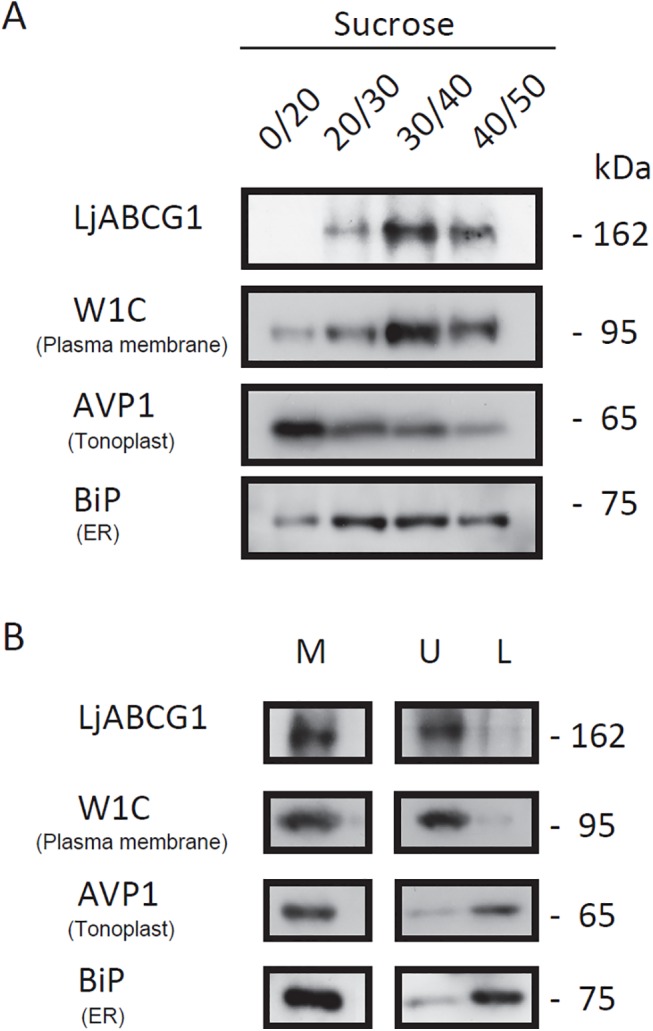
Subcellular localization.(A) Total microsomes from super roots were fractionated on a discontinuous sucrose gradient consisting of 20%, 30%, 40%, and 50% (w/v) sucrose. Membrane fractions were collected from the interfaces between different sucrose concentrations and analyzed via SDS-PAGE and western blotting. Blots were probed with antisera to LjABCG1, PM H+-ATPase (W1C), tonoplast and endomembrane H+-PPase (AVP1), and endoplasmic reticulum BiP (BiP). (B) Two-phase separation of plasma membrane. Microsomal membranes (M) from super roots were fractionated by the aqueous two-phase portioning method, with plasma membranes enriched in the upper phase (U) and other intracellular membranes remaining in the lower phase (L). Proteins from each fraction were blotted and probed with antisera to LjABCG1, PM H+-ATPase (W1C), tonoplast and endomembrane H+-PPase (AVP1), and endoplasmic reticulum BiP (BiP).